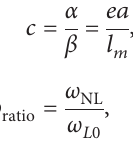
Figure 4: The variation of the nonlinear frequencies of the FG nanobeams to the material length scale parameter for k � 5, L / h � 15, and � 0 . 01: (a) without thickness effect; (b) with thickness V 0